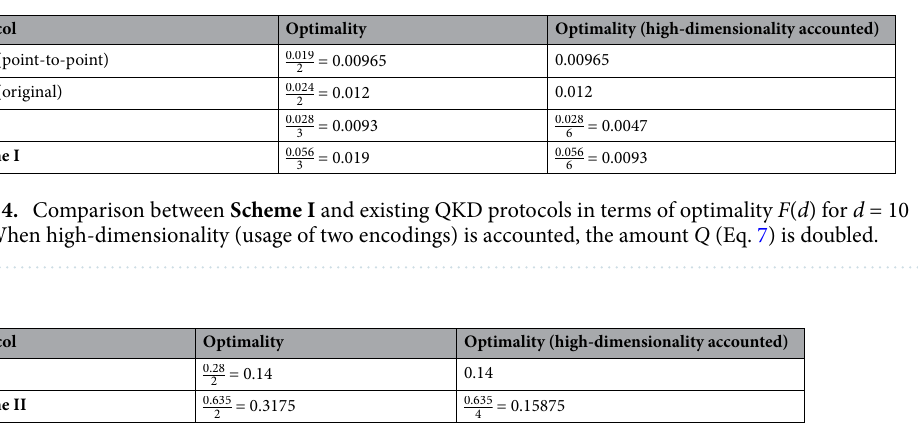
Protocol Optimality